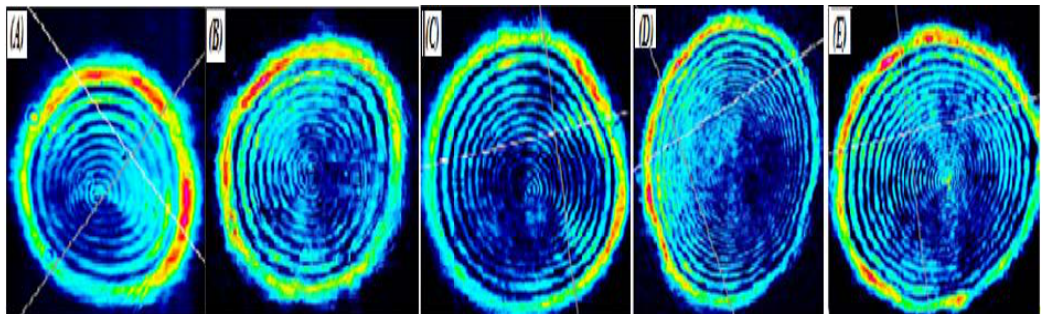
Fig.14: Non-linear diffraction pattern produced by SWCNTs at volume fraction 6x10 -5 at laser intensity (A) 130.41, (B) 169.81, (C) 238.31, (D) 285.69, and (E) 353.38 W / cm 2 .